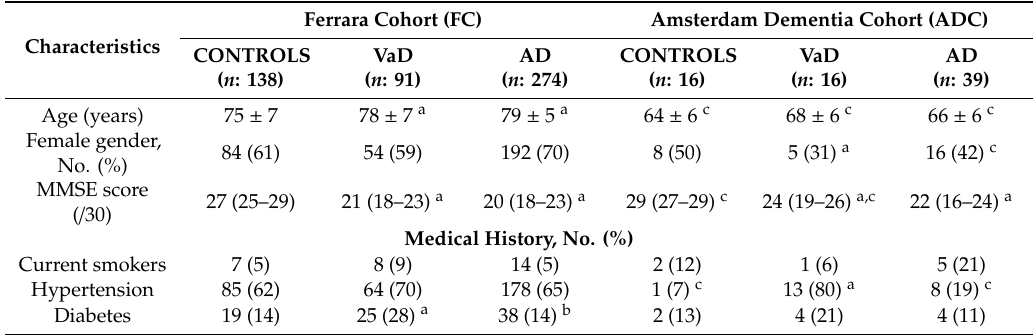
Table 1. Principal characteristics of the Ferrara cohort (FC) and Amsterdam Dementia cohort (ADC). Ferrara Cohort (FC) Amsterdam Dementia Cohort Characteristics